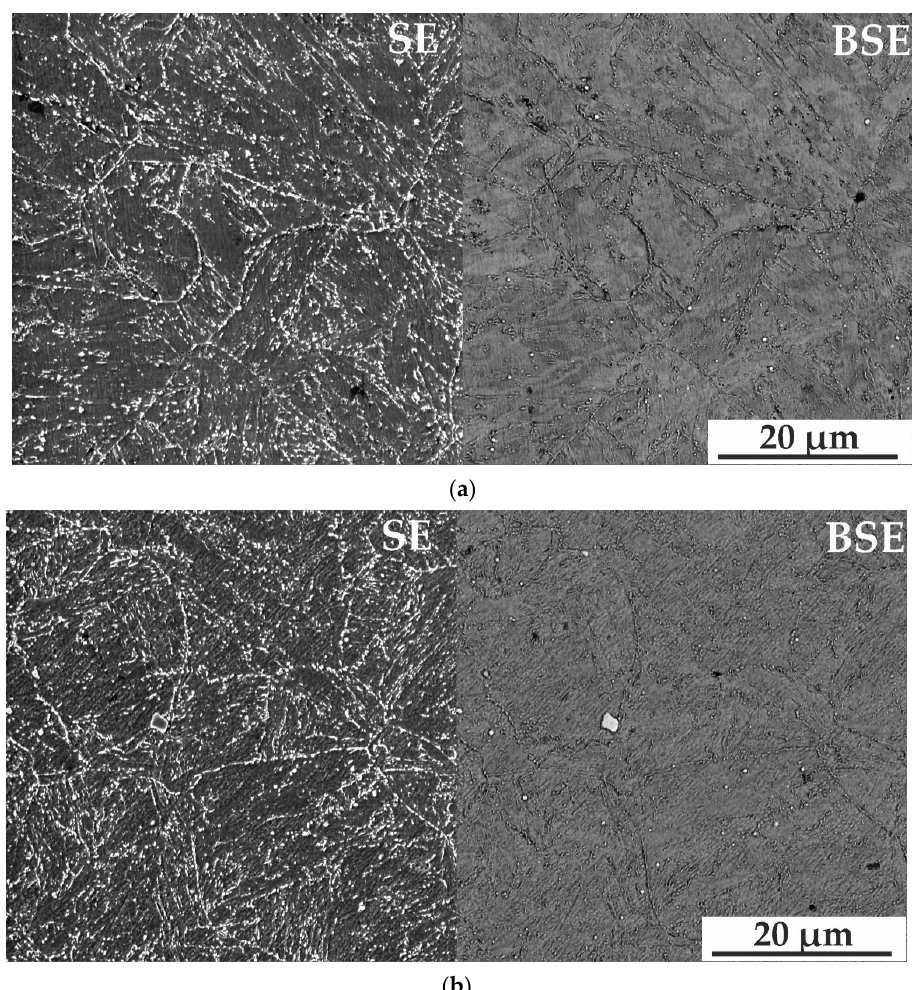
Figure 4. SEM images of etched steel microstructure after THT ( a ) and HTMT ( b ), SE images (left) and BSE images (right).